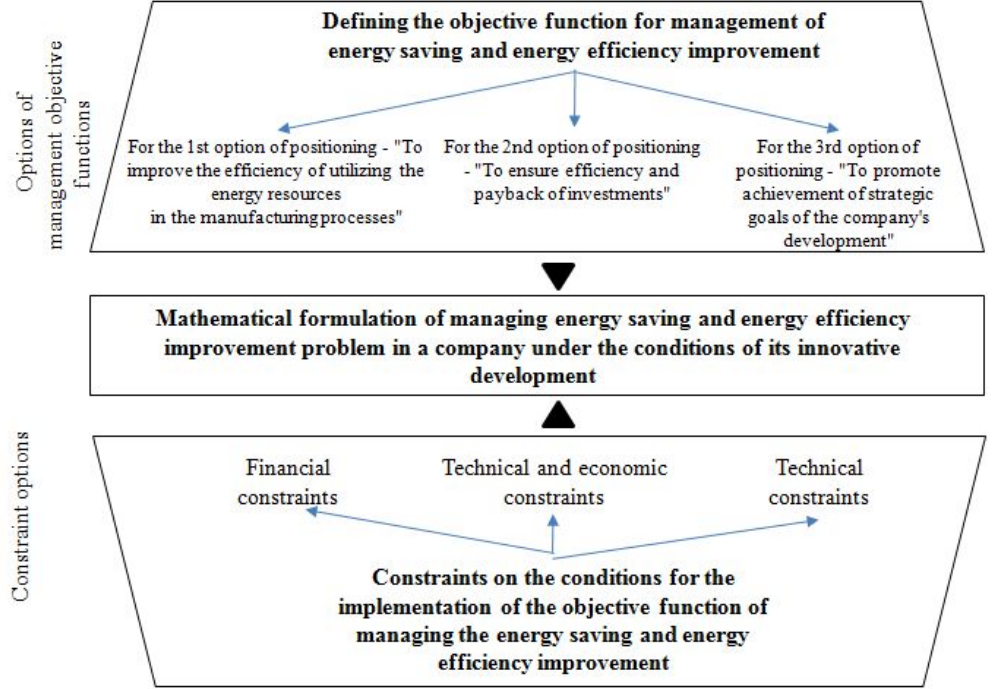
Figure 1. Defining the target function of energy saving and energy efficiency improvement and restrictions on the conditions of its implementation under different options of their positioning (source: compiled by the authors).